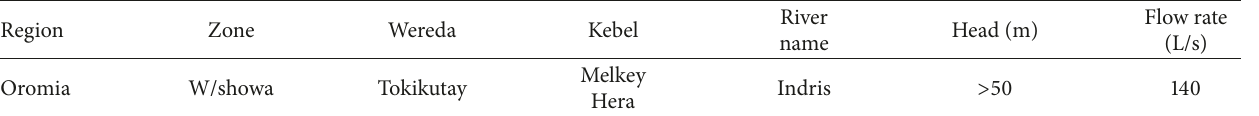
Table 2: Proposed site data for MHP development